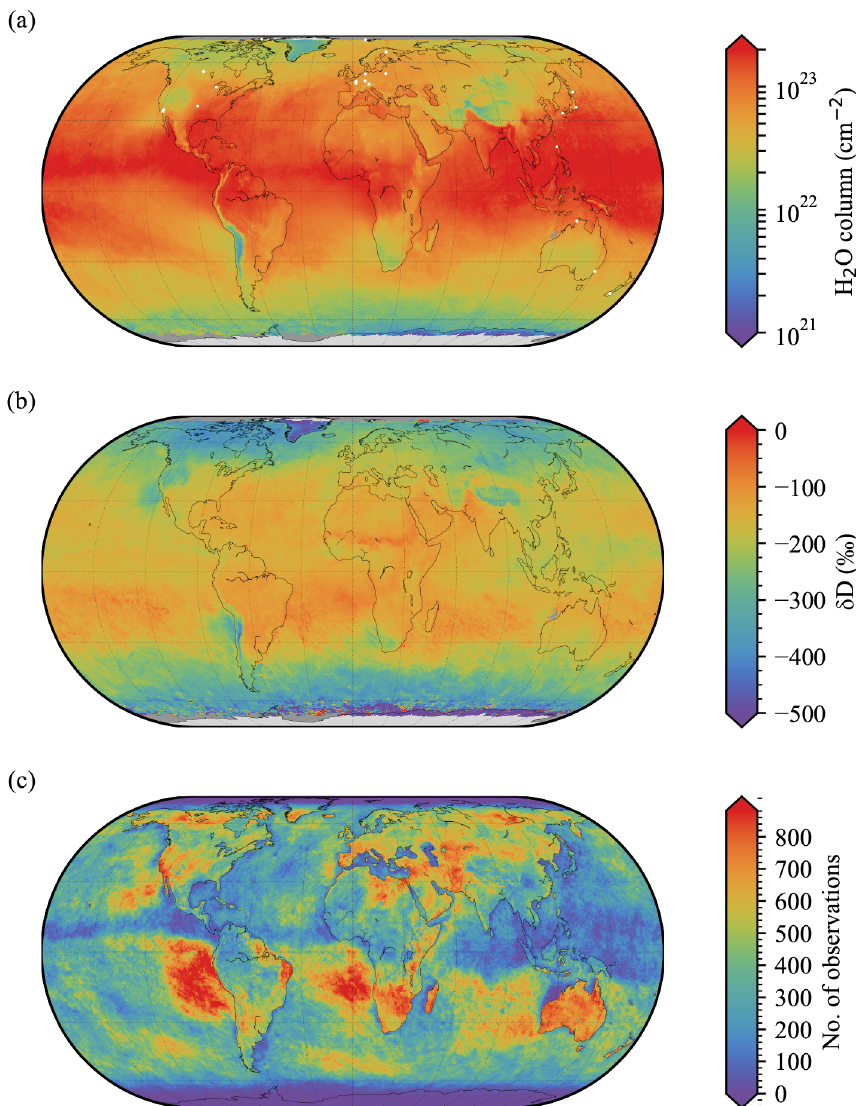
Figure 16. Global plots of (a) average H 2 O, (b) average δ D, and (c) number of observations for September 2018 on a 0 . 5 ◦ × 0 . 5 ◦ grid. The average of δ D is weighted with the H 2 O column. The white points in (a) show the locations of the TCCON stations used for validation in Sect.